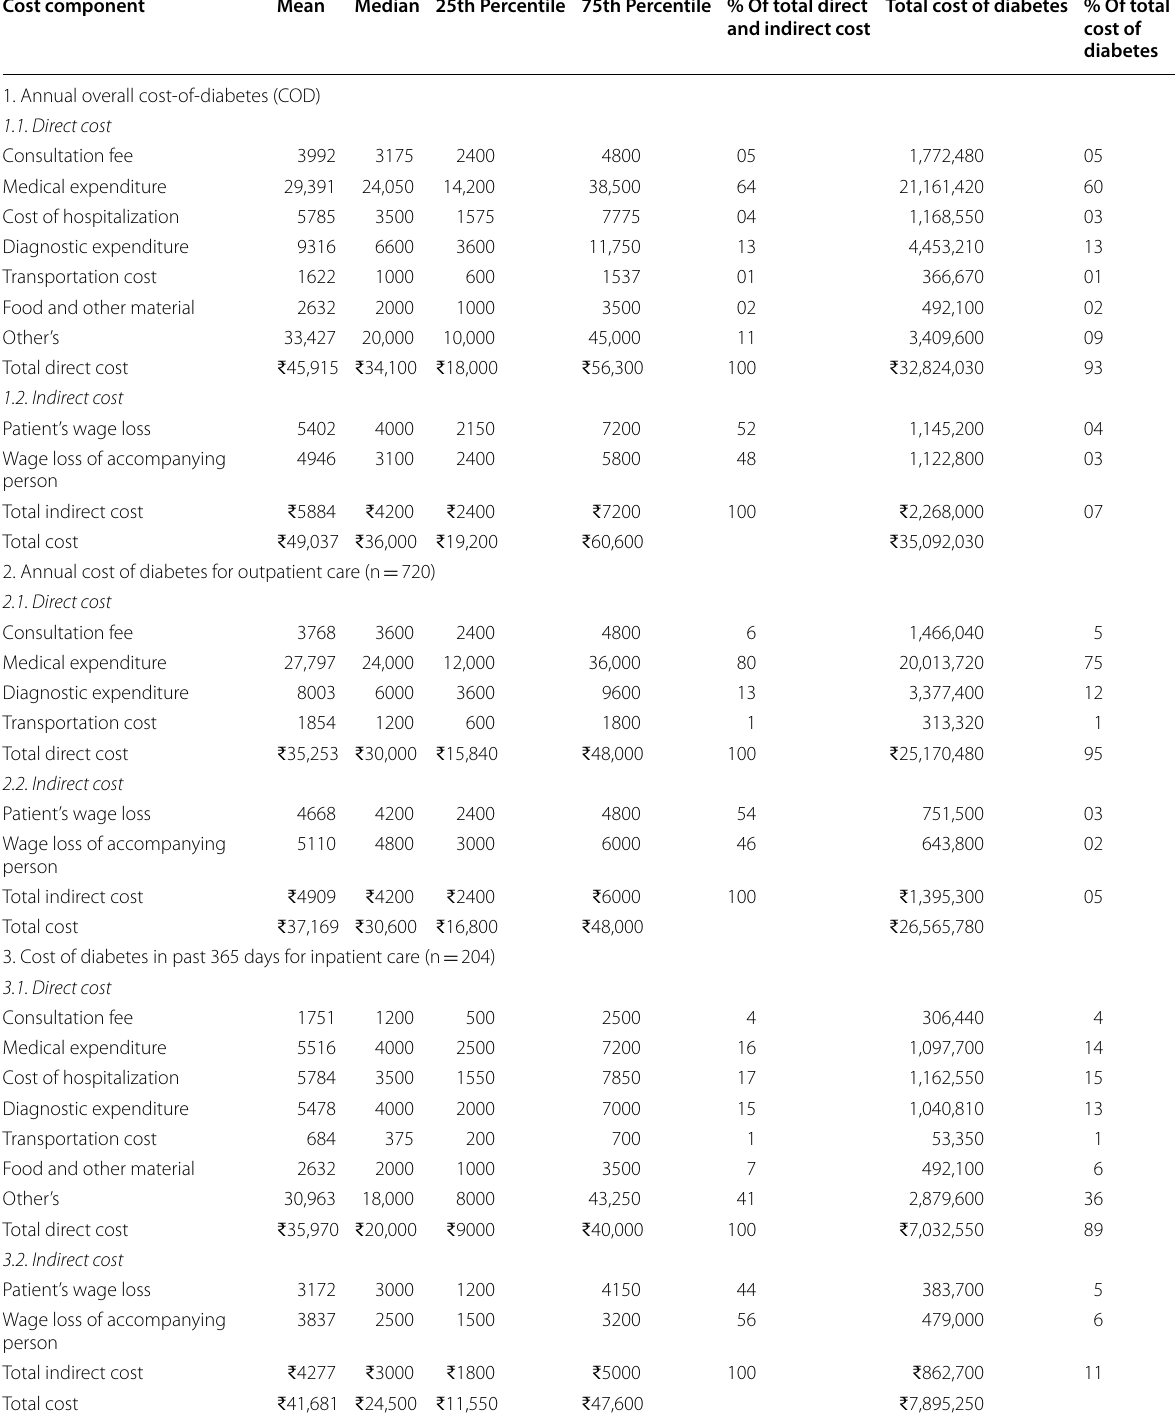
Table 3 Annual cost of diabetes by component of direct and indirect cost ( ₹ ) in